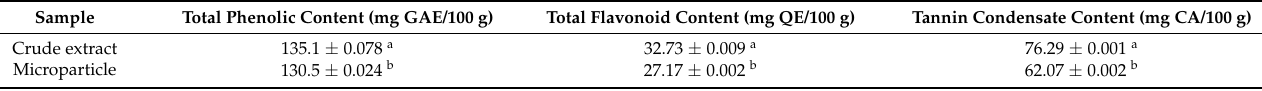
Experiments were executed in triplicate and the data are presented as mean ± standard deviation (SD). Different letters in the same column indicate significant difference ( p < 0.01). GAE = gallic acid equivalent, QE = quercetin equivalent and CAE = catechin equivalent.